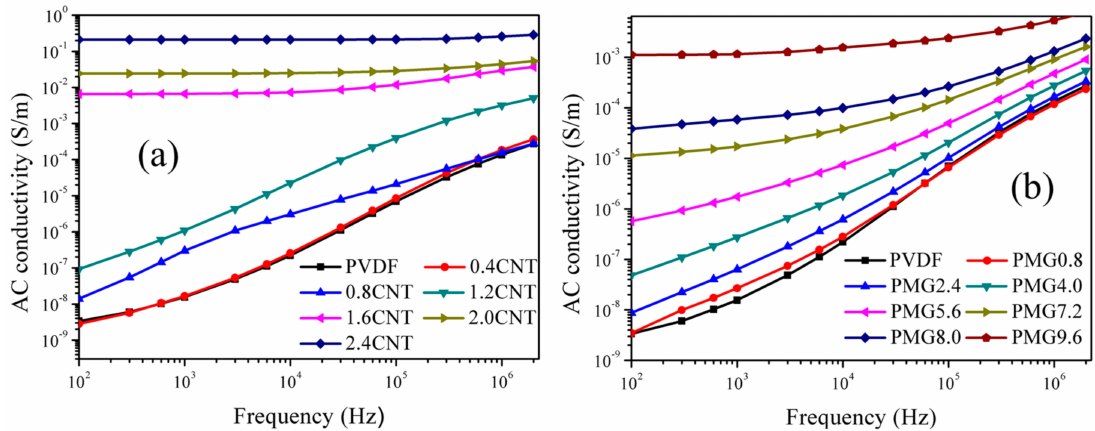
Figure 9. Frequency dependent of the ac conductivity of ( a ) c-MWCNTs/PVDF and ( b ) c-MWCNTs/MG/PVDF composites with different c-MWCNTs contents.